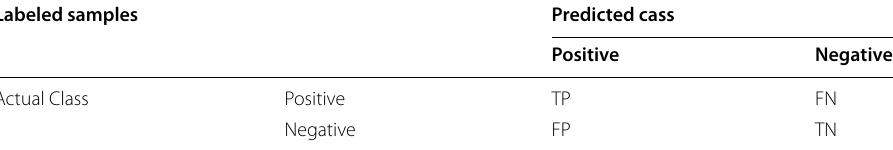
Table 5 Simplified confusion matrix Labeled